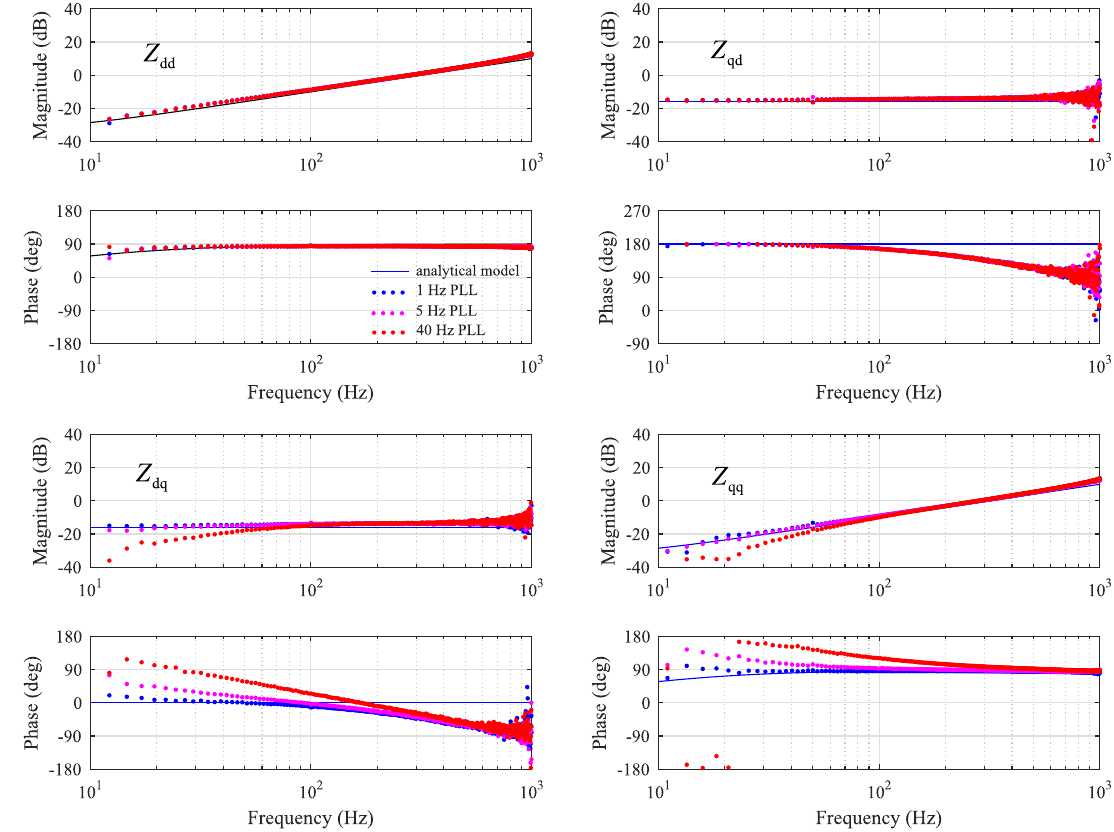
Figure 9. Impedance components extracted using the emulated inverter as an excitation source with different phase-locked-loop (SRF-PLL) crossover